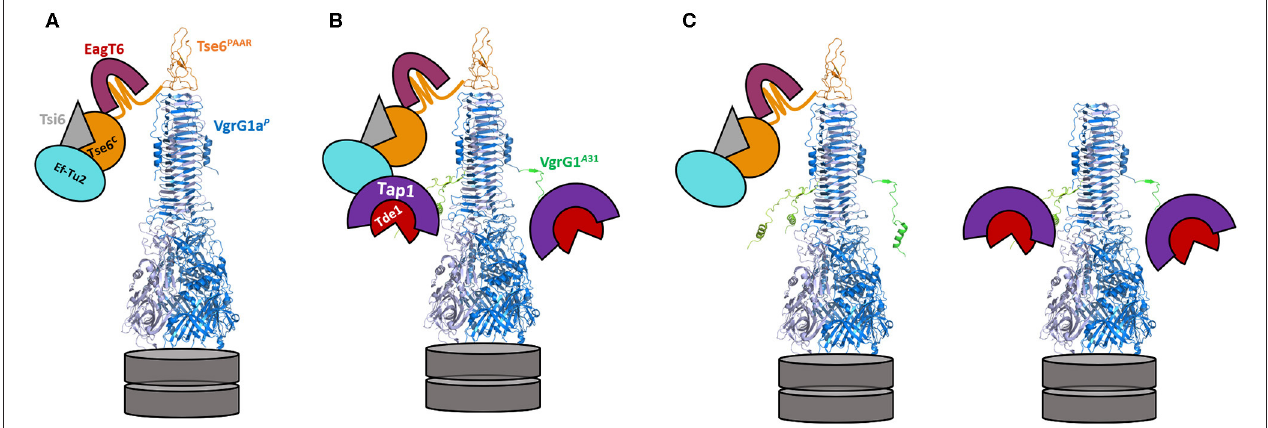
FIGURE 6 | Model of the decoration of the VgrG1a/chimera A-tip in absence and presence of Tap-Tde1. VgrG1a P is represented as a blue trimer (pdb: 4mtk), topped by the PAAR domain of Tse6 (orange) with the C-terminal domain of Tse6 floating around the tip bound to its cognate immunity Tsi6 (gray). The chaperone EagT6 (magenta) and the elongation factor EfTu2 (cyan) additionally bind the C-terminal toxin domain of Tse6. (A) Configuration of the VgrG1a tip in the parental strain. (B) In cells expressing construct A, VgrG1a is extended by 31 aa originally from VgrG1 A (green) resulting in an extended VgrG spike protein. In the presence of Tap (purple) and Tde1 (red), three Tap1-Tde1-complexes bind to each of the C-terminal extensions of chimera A (only two are shown here) leading to a sterically crowded complex tip. (C) Two construct A spikes coexist in P. aeruginosa cells. One complex is comparable to the WT spike with Tse6 binding to the three last β -strands of construct A, resulting in a secretion-competent T6SS tip. A second complex interacts with the Tap1-Tde1-complex but not with Tse6 and this complex cannot be secreted resulting in less overall secretion of construct A in comparison to VgrG1a spikes.